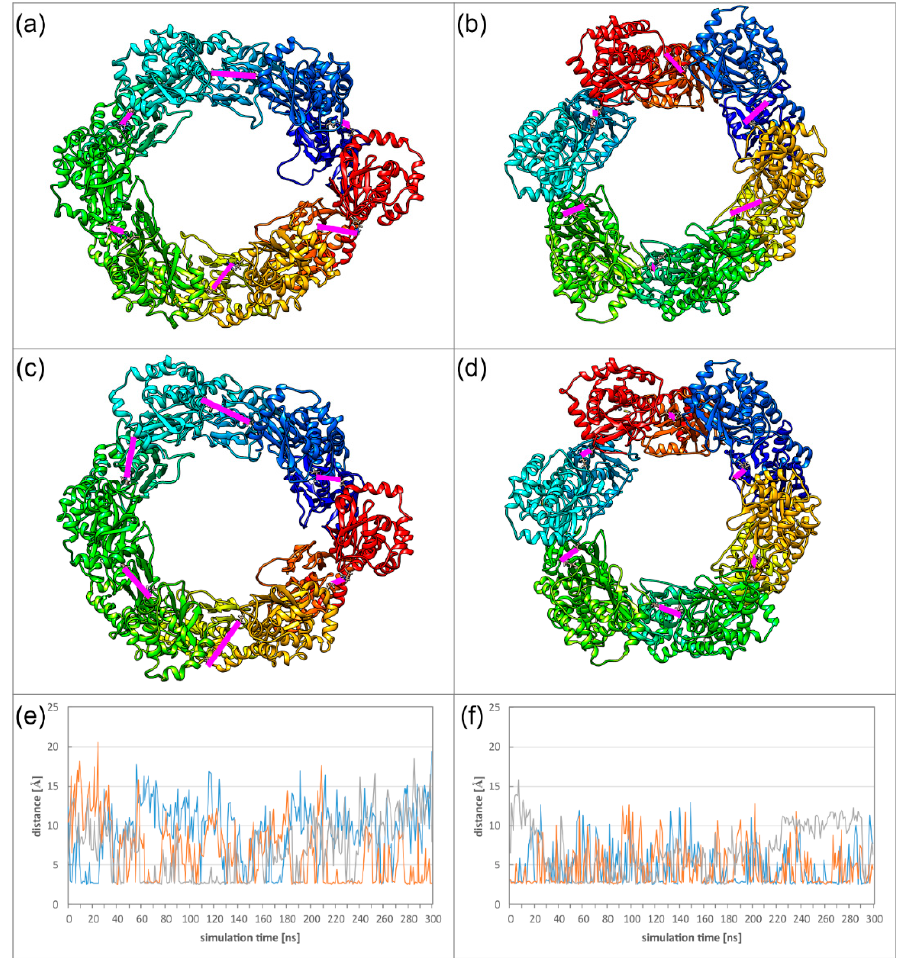
Figure 8. ( a – d ) Two alternative conformations of the HCMV ( a , c ) and HSV ‐ 1 ( b , d ) Hexagons observed during the MD (molecular dynamics) simulations. Each chain is coloured individually. Inter ‐ subunit distances between E282R225 (HCMV) or E302K262 (HSV ‐ 1) of OIF I are highlighted with pink bars. For three of these six OIF I interactions, the time course is displayed in panels ( e , f ): HCMV ( e ), and HSV ‐ 1 ( f ).